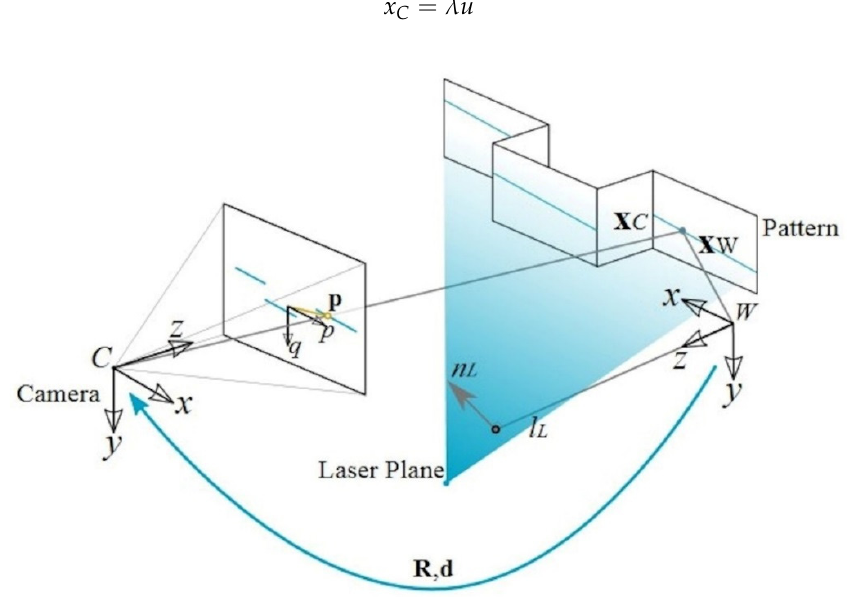
Figure 3. Laser triangulation system. The calibration processes consist of identifying extrinsic and intrinsic parameters of both elements followed by the measurement process for the image. Here, x C and x W correspond to laser point p taken in the image and projected in the pattern following unitary vector u, for both the camera coordinates ( C ) and world coordinates ( W ), with a transformation matrix R,d. Additionally, n L and l L correspond to laser parameters.